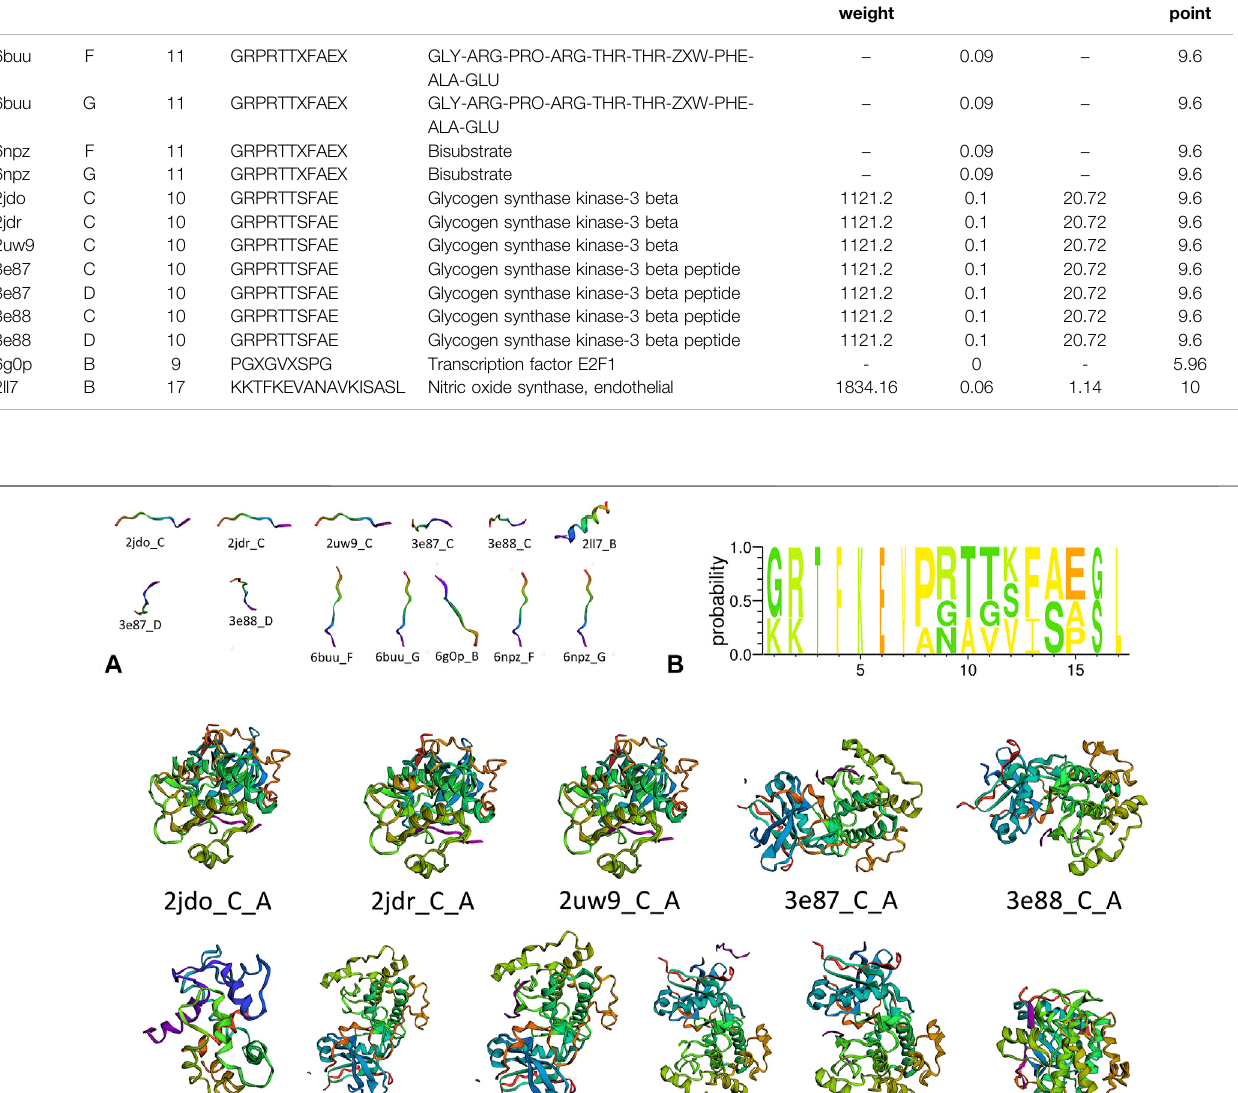
Frontiers in Genetics |